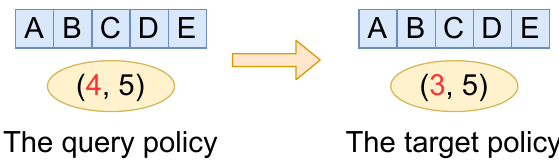
Figure 4. An example of the second